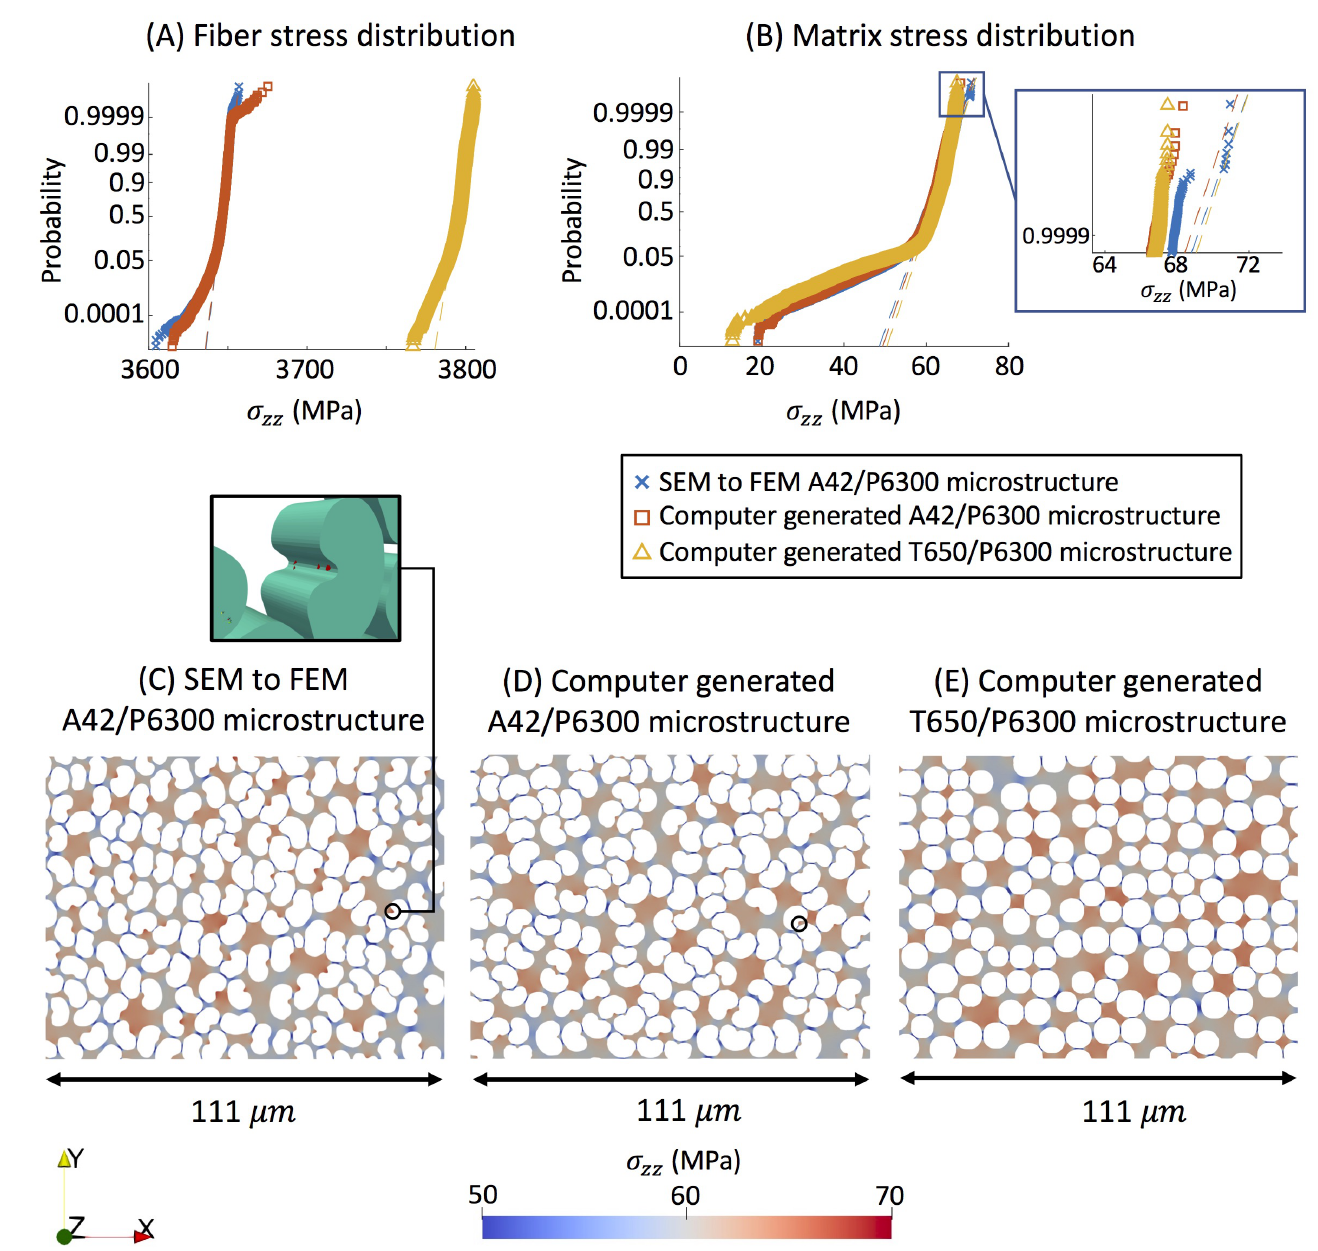
Figure 3. The probability plots of stress in the loading direction, σ zz , for ( A ) the fibers, and ( B ) the matrix, for the real A42/P6300 microstructure, the computer generated A42/P6300 microstructure, and the computer generated T650/P6300 microstructure when elongated by 1.5% in the fiber direction. The stress results for σ zz (cropped away from the boundary conditions) are also shown in ( C ) for the real A42/P6300 microstructure from the SEM image, ( D ) for the computer generated A42/P6300 microstructure with random in-plane orientations, and ( E ) for the computer generated T650/P6300 microstructure. Black circles in ( C , D ) point out the location of simulated failure determined by a simulation using a